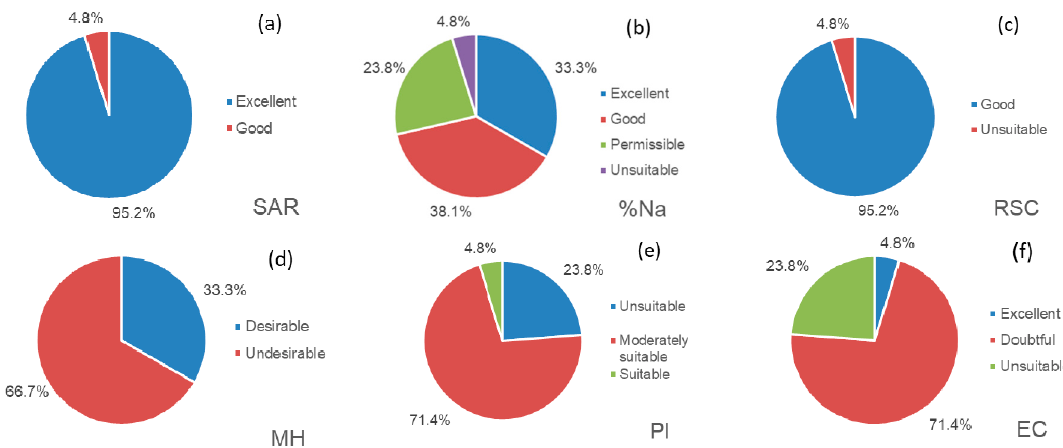
Figure 4. Proportion of groundwater suitable for irrigation based on different indexes: ( a ) sodium adsorption ratio (SAR), ( b ) sodium percentage (%Na), ( c ) residual sodium carbonate (RSC), ( d ) magnesium hazard (MH), ( e ) permotic index (PI) and ( f ) electrical conductivity (EC).